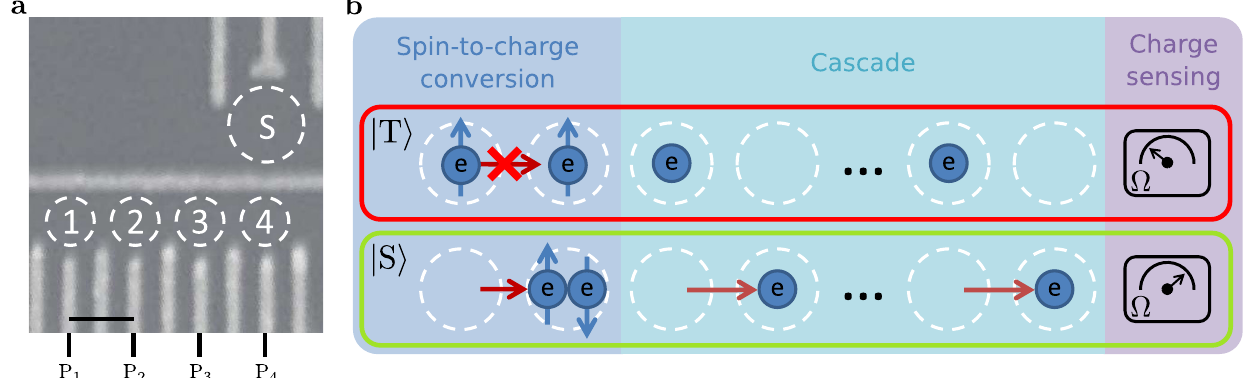
Fig. 1 Device and cascade concept. a Scanning electron micrograph of a device nominally identical to the one used for the experiments. Dashed circles labelled with numbers indicate quantum dots in the array, and the dashed circle labelled with ‘ S' is the sensing dot. The scale bar corresponds to 160 nm. b Schematic illustration of spin-to-charge conversion combined with a cascade for electron spin readout on dots far from the charge